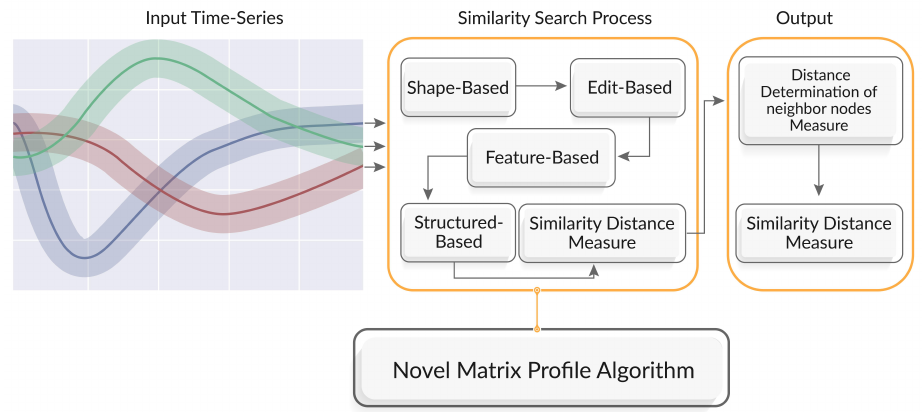
Figure 2. Proposed model for time series data set supported with NMP